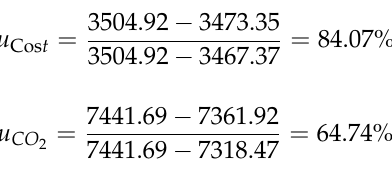
Table 4. Optimal results of multi-objectives.